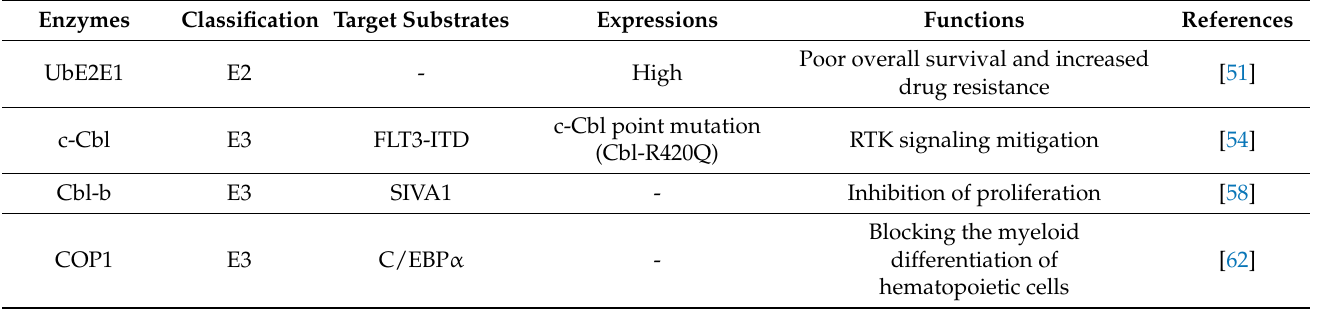
Table 3. Ubiquitination-related enzymes and substrates, and their expressions and functions in AML.